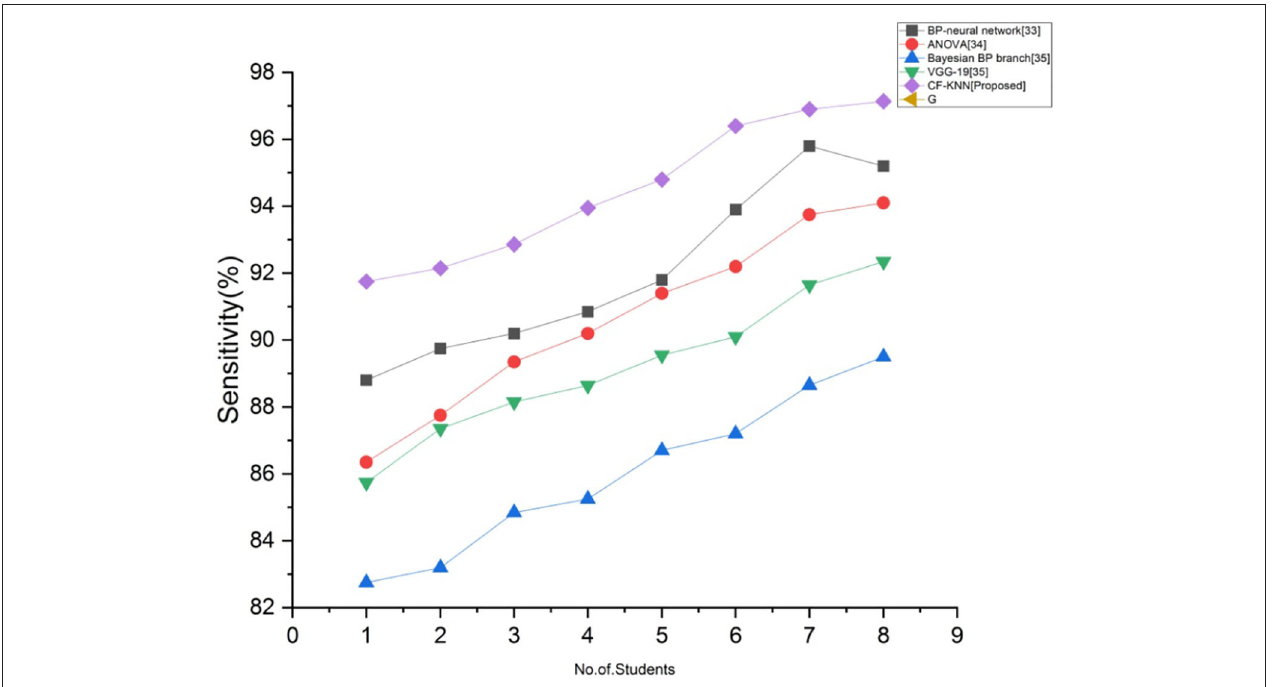
FIGURE 9 | Comparison of sensitivity with proposed and existing techniques.